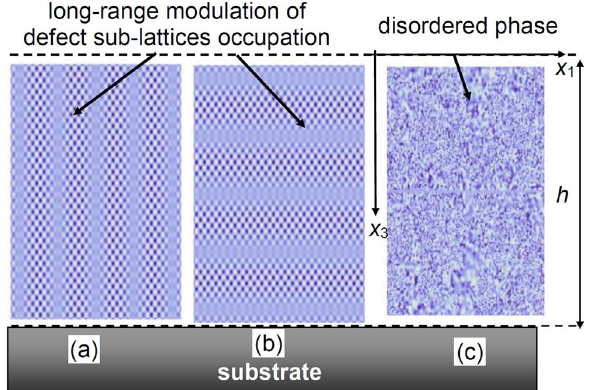
Figure 1. Point defect ordering in ultra-thin oxide film of thickness h placed on a rigid substrate. One can distinguish perpendicular ( a , the left side) and parallel ( b , the central part) orientations of the defect ordering from the state with randomly distributed defects ( c , the right side). Parts ( a ) and ( b ) illustrate how the harmonic modulations of the order parameter reveal local redistribution of defects between defect